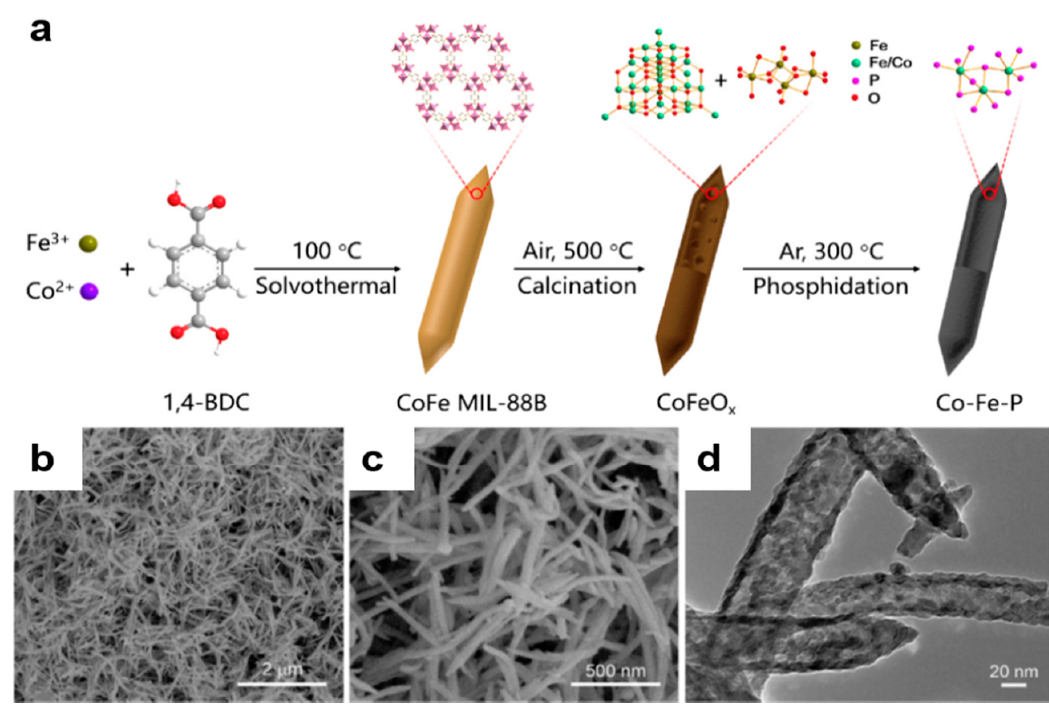
Figure 6. ( a ) Schematic illustration of the synthesis of Co–Fe–P nanotubes; ( b , c ) SEM and ( d )